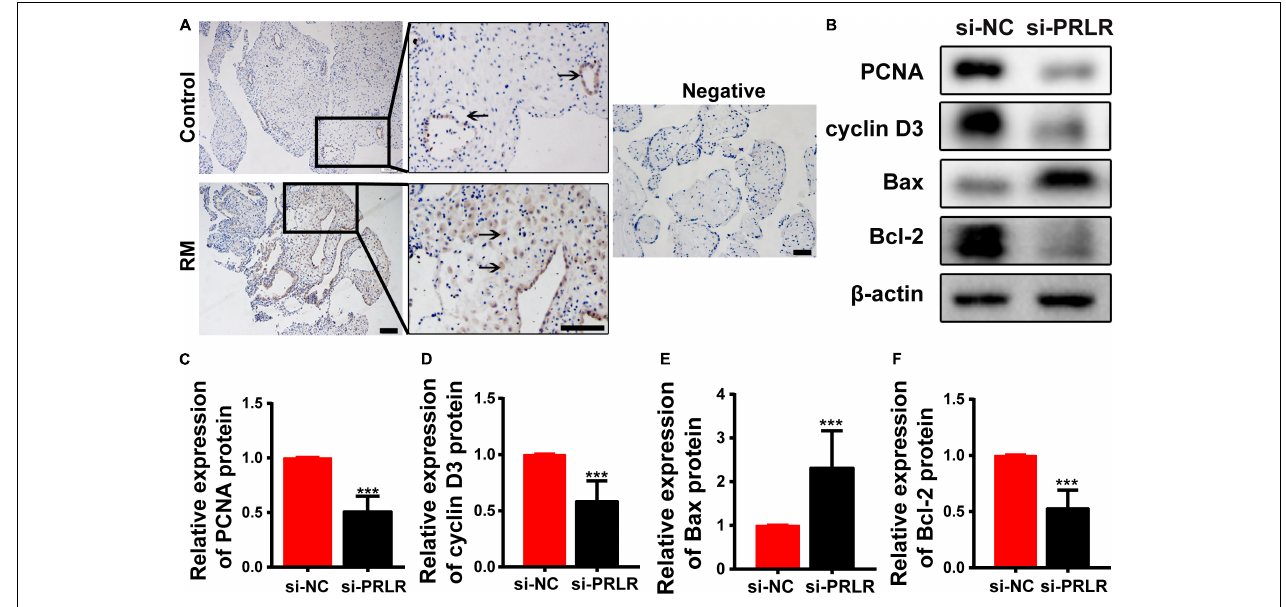
FIGURE 3 | Circ-CYP24A1 regulated cell proliferation and apoptosis via the miR-224_PRLR axis. (A) Expression of PRLR was detected using immunohistochemical staining in the decidua of patients with early RM and unintended pregnant women. (B) Expression of proliferation-related markers was detected using Western blotting in Ishikawa cells transfected with PRLR siRNA. (C–F) Gray analysis of B. RM, early recurrent miscarriage; control, unintended pregnant women; si-NC, negative control to siRNA (*** p < 0.005). Scale bar: 100 µ